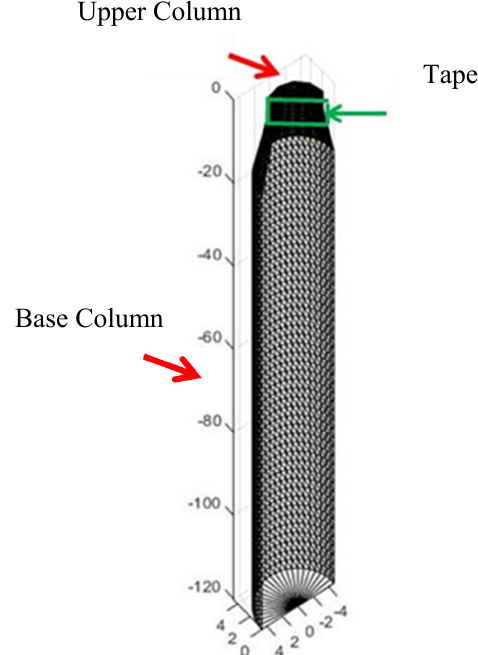
Table 2. Panel properties of the wetted hull for the OC3-Hywind spar / UMaine-Hywind spar.